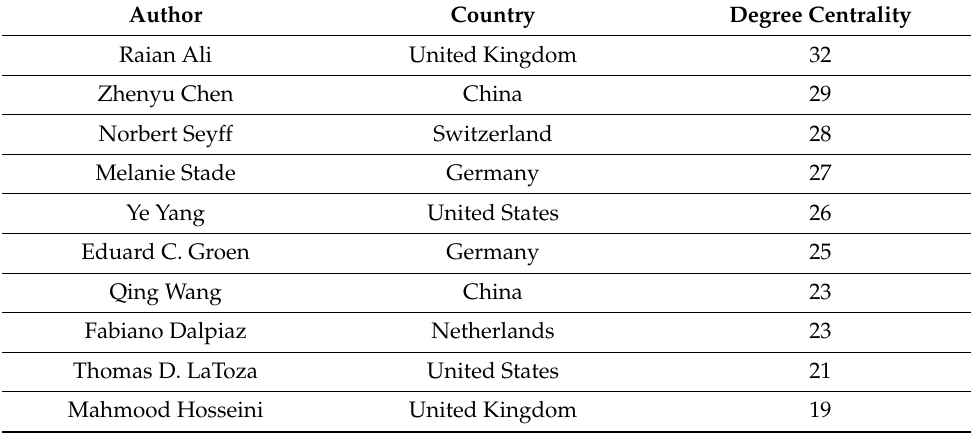
Table 6. Degree of centrality of authors in the CSE co-authorship network.